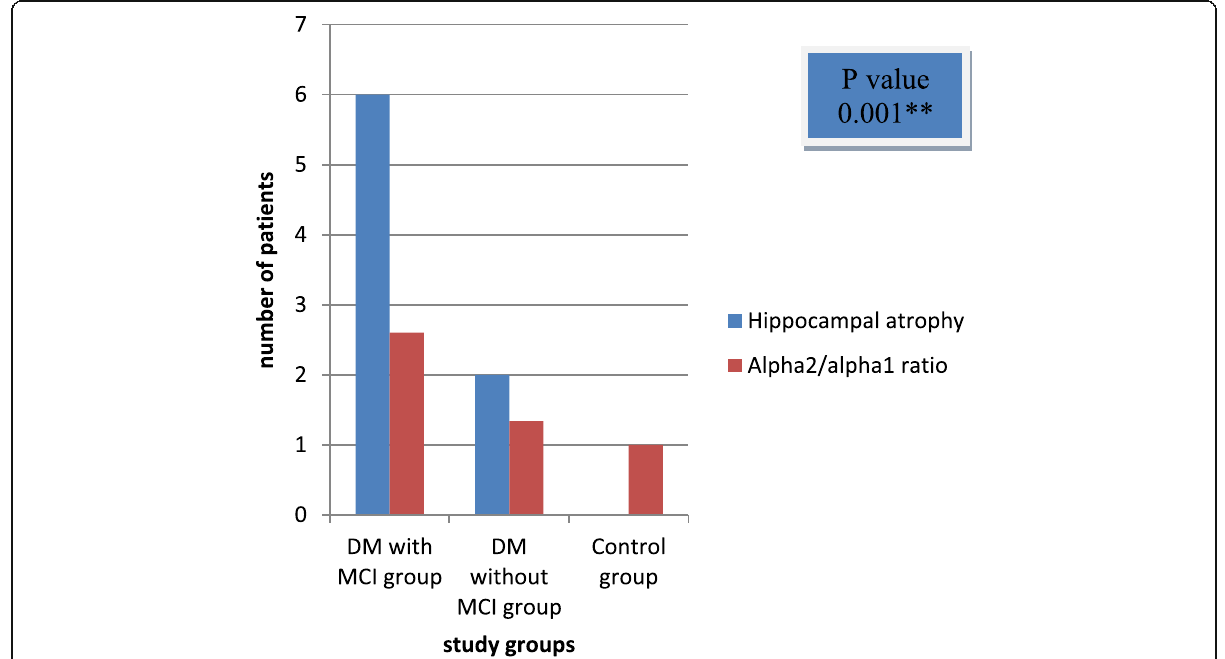
Fig. 2 Distribution of hippocampal atrophy and alpha 2/alpha 1 ratio among the study groups. DM = diabetes mellitus, MCI = mild cognitive